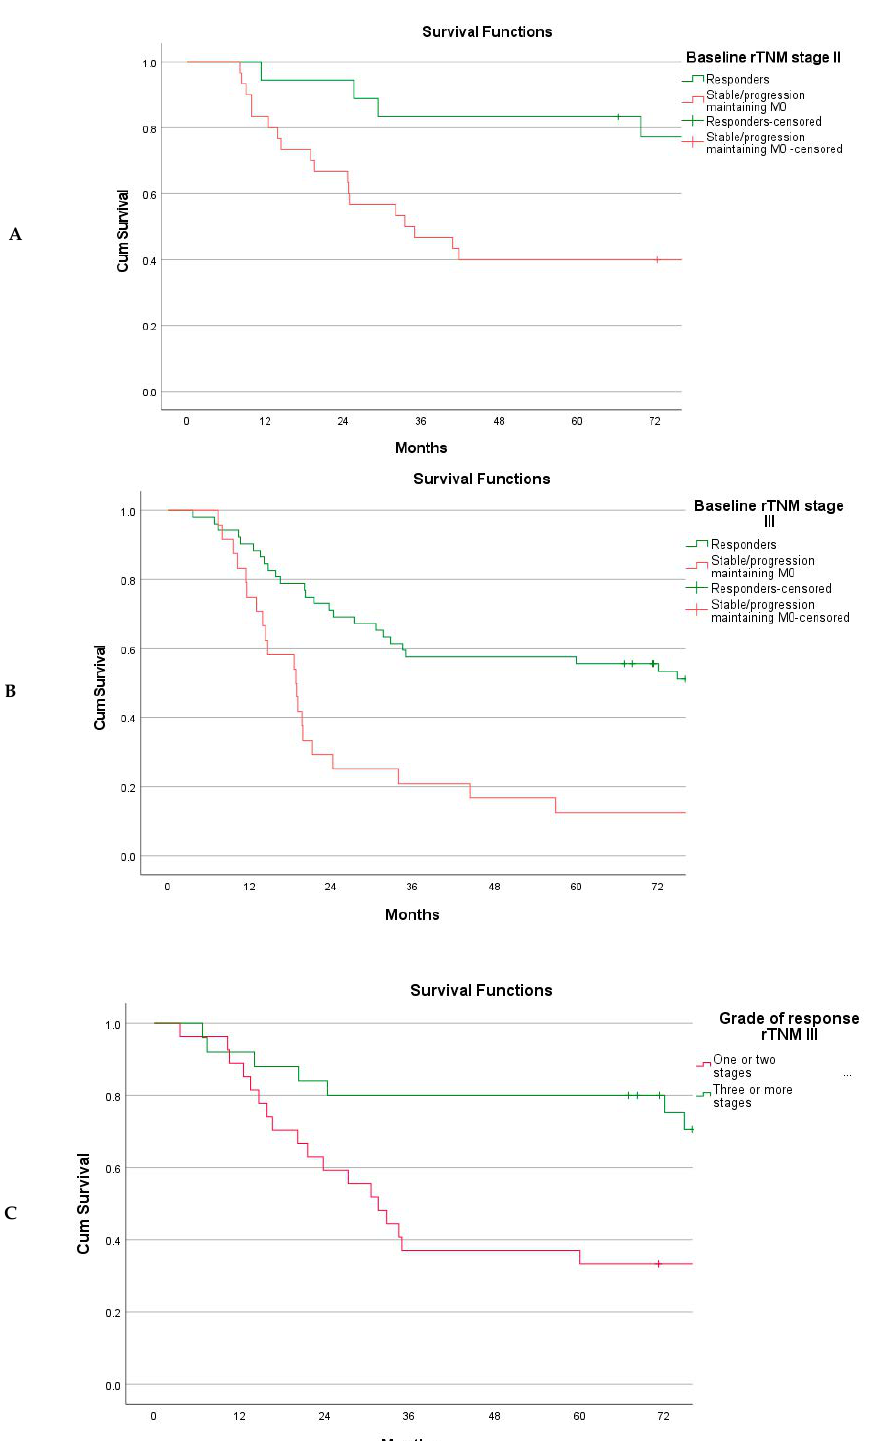
Figure 3. ( A ) Overall survival strati fi ed on the basis of the TNM response mode, n = 164. Response ( n = 78), stable disease ( n = 25), and progression ( n = 61). Global log-rank p < 0.001. Response vs. stable p = 0.012. Stable vs. progression p = 0.020. ( B ) : Overall survival based on TNM response mode. Disease progression further subdivided into progression maintaining M0 status ( n = 35) and pro- gression to metastatic disease M+ ( n = 26). Stable disease vs. progression maintaining M0, log-rank p = 0.512.